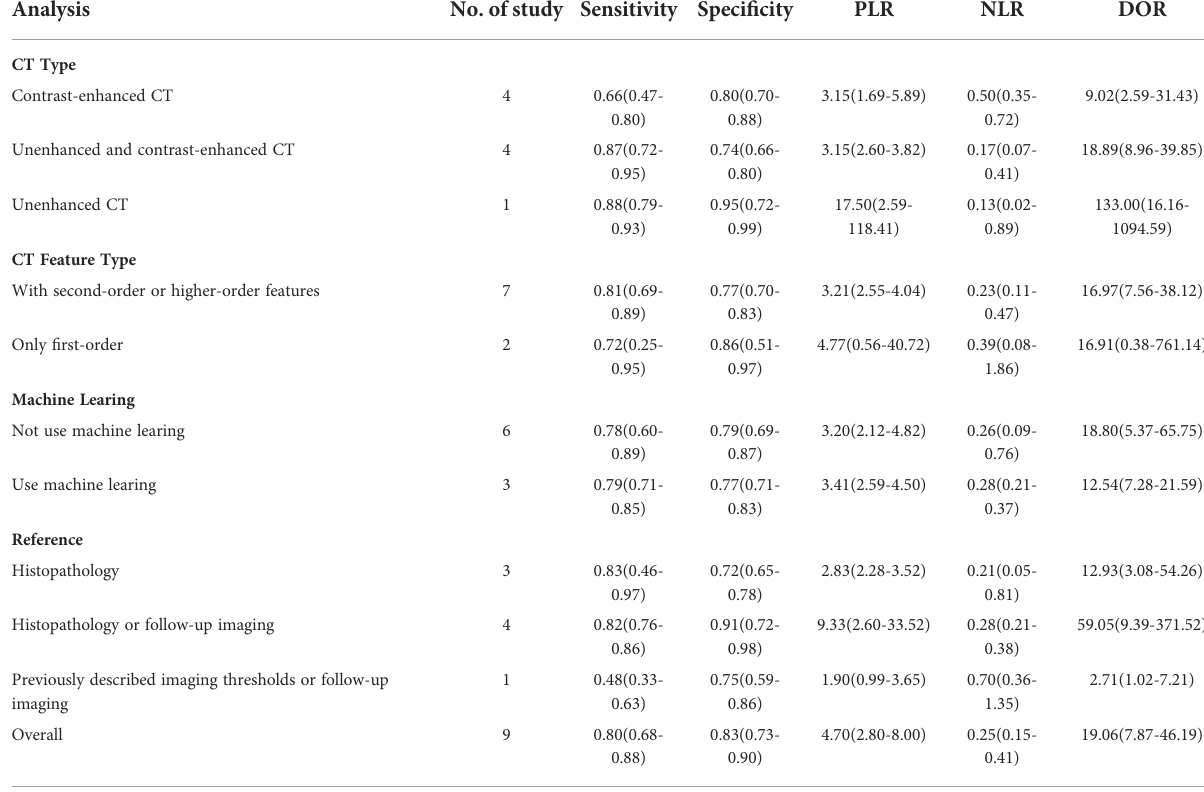
TABLE 6 The results of subgroup analysis.